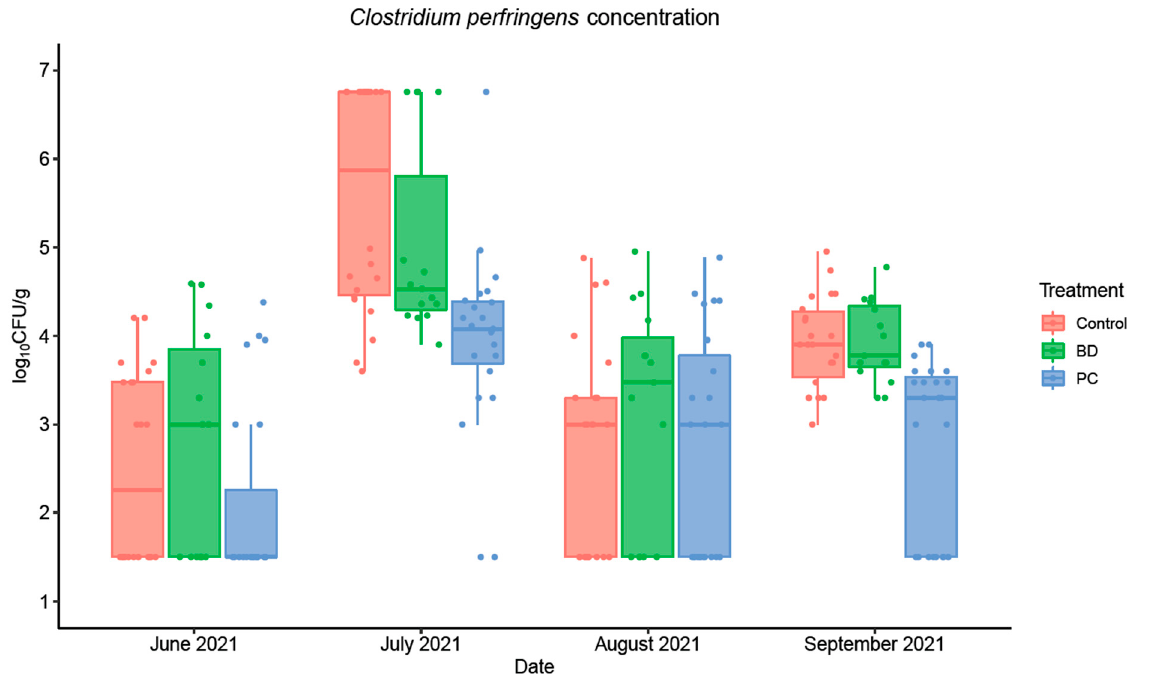
Figure 3. C. perfringens average concentration (log 10 CFU/g) in fecal samples collected from the pen floors over the course of a 4-month sampling period at three different feed yards ( n = 3 pens/feed yard). Error bars represent 95% confidence intervals (CI).